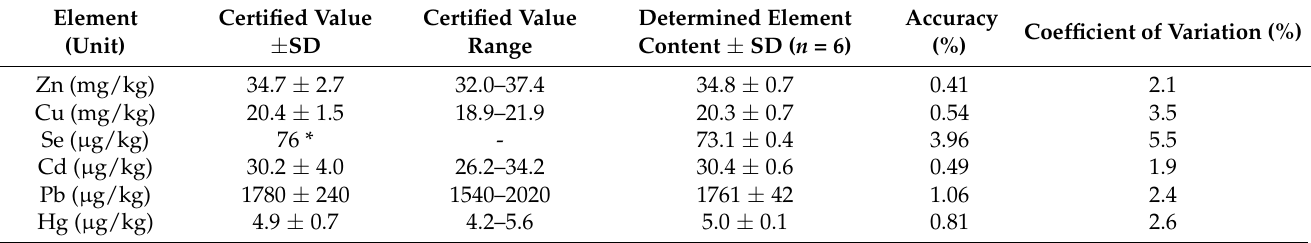
Table 2. Results of quality control of the methods for determination of Zn, Cu, Se, Cd, Pb, Hg in certified reference material. Element